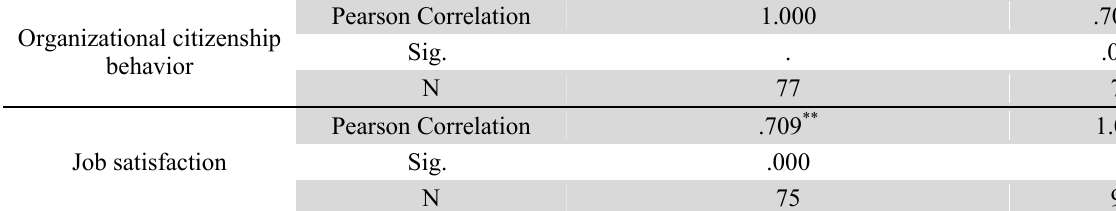
The summary of Pearson correlation ratio between organizational citizenship behavior and job satisfaction Organizational citizenship